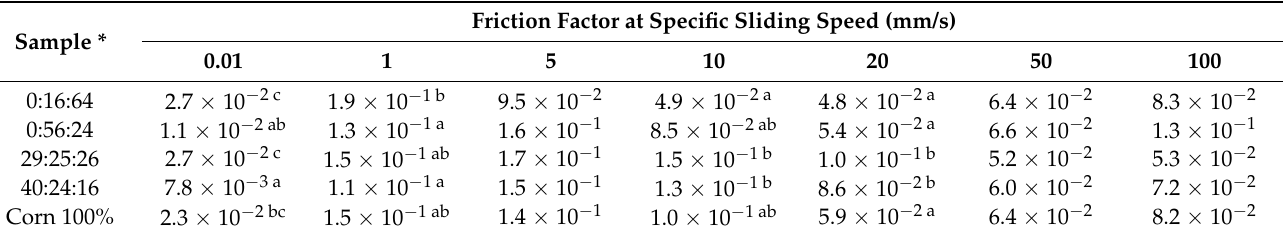
Table 5. Mean tribological behaviors of extrudates with different levels of